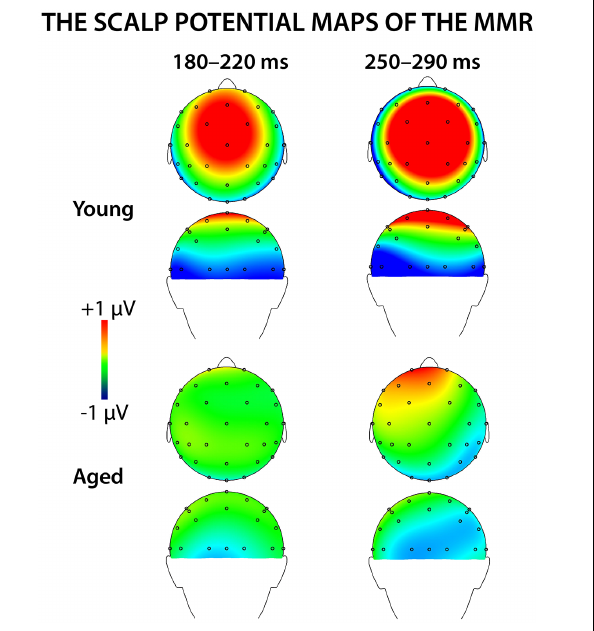
FIGURE 4 |The voltage distribution maps for the early and late MMR in young and aged.